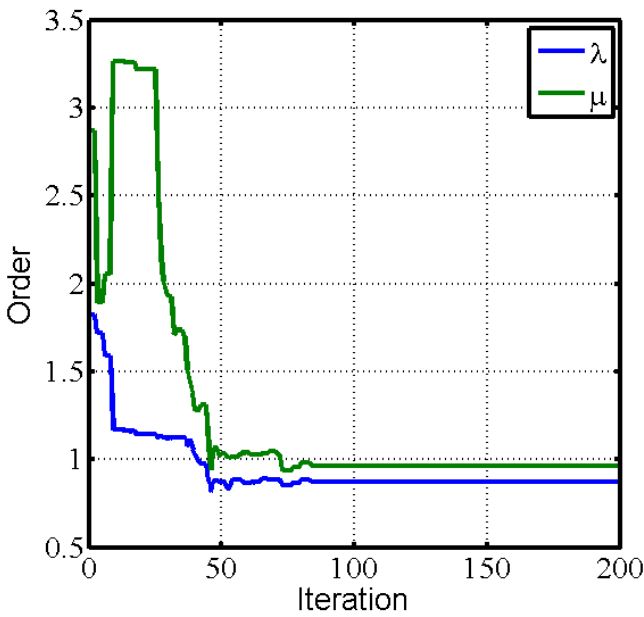
Figure 16. Evolutionary curve of estimated parameters ( λ , µ ) for FOPID controller without operator.